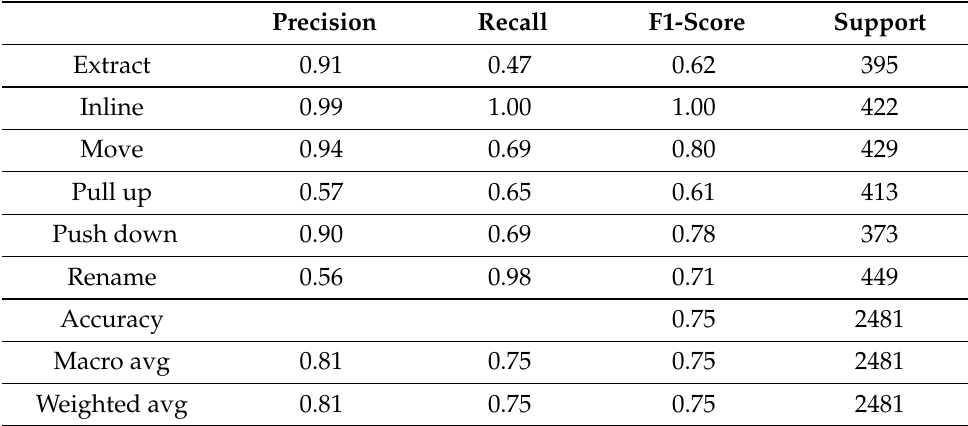
Table 7. Results of random forest algorithm. Precision